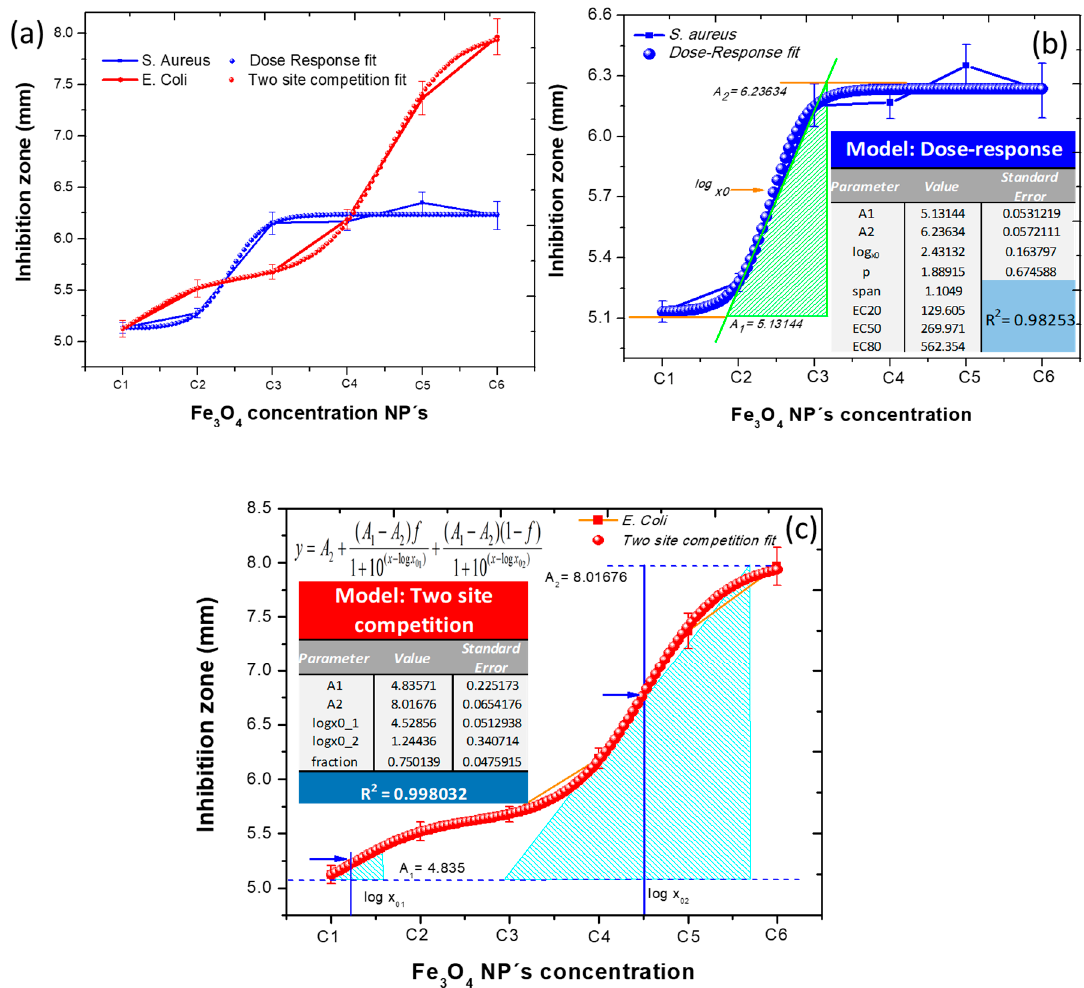
Figure 11. Antibacterial curve fitting ( a ) comparison between E. coli and S. aureus. ( b ) S. aureus behavior (dose response model) and ( c ) E. Coli behavior (two sites competition model).